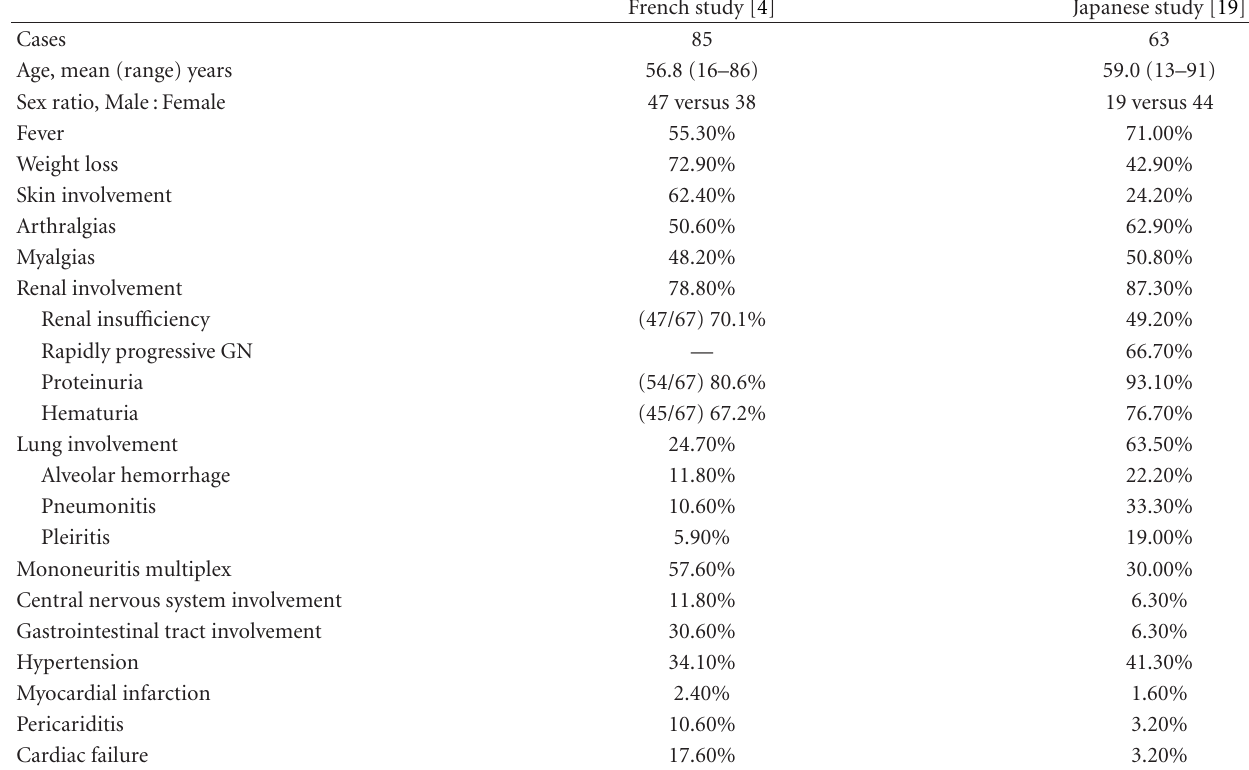
Table 1: Comparison of clinical manifestations in MPA between French and Japanese